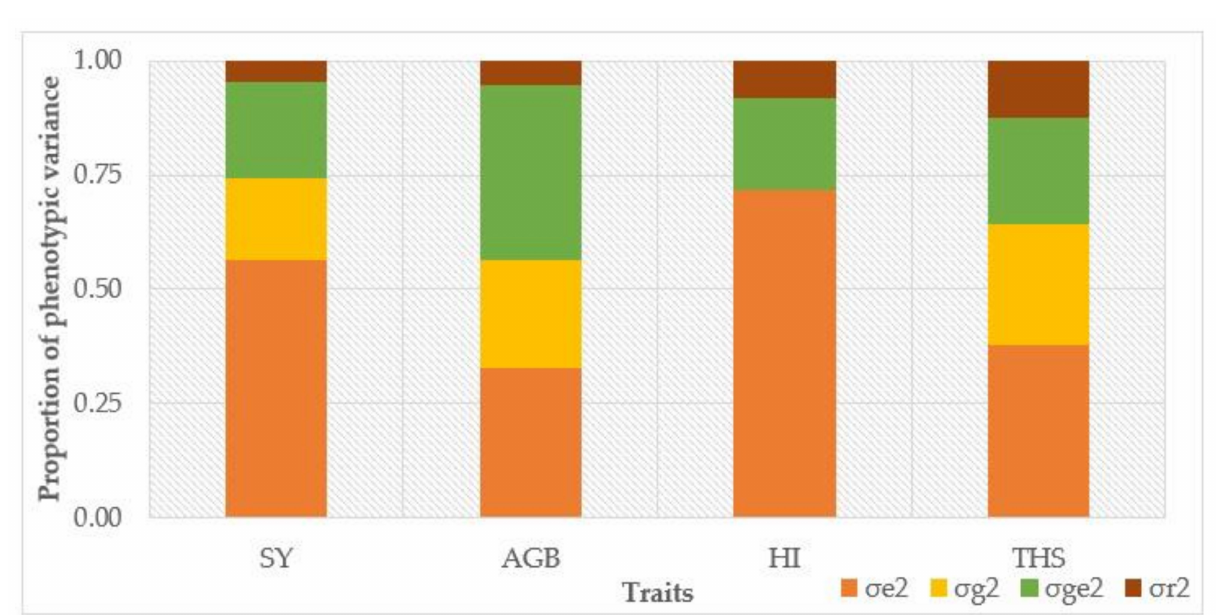
Figure 2. Proportion of the phenotypic variance for four chickpea traits (SY, AGB, HI, and THS) evaluated during three consecutive growing seasons. SY = Seed yield; AGB = Above ground biomass; HI = Harvest index and THS = 1000 seed weight. σ e2 = environment variance; σ g2 = genotype variance; σ ge2 = interaction g × e variance and σ r2 = residual